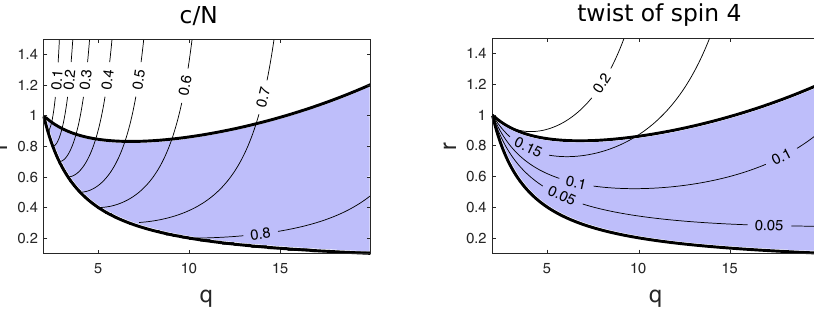
Figure 6 . The ( q; r ) parameter space of the d = 2 model (6.18). We draw contours of the central charge per degree of freedom c=N and the twist 2 e h of the lightest spin-four operator. At the very least, the region outside the shaded region is disallowed: the lower boundary is the constraint (6.28) and the upper boundary is the constraint that the eigenvalues of k (1 = 2 ; 1 = 2) are less than one. It is not clear if the model (6.18) can be made to (cid:13)ow to desired IR (cid:12)xed point even within the shaded